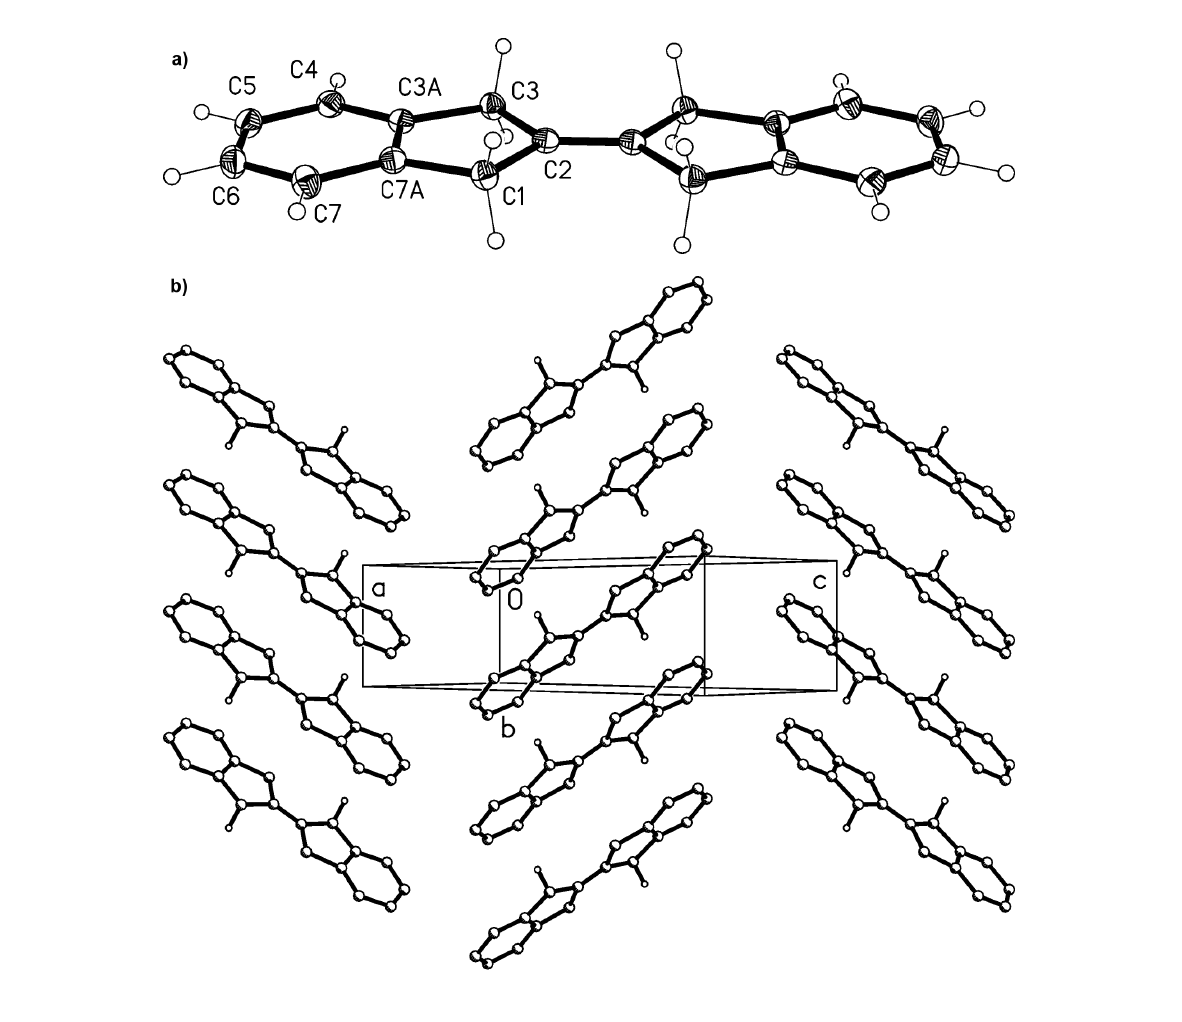
Figure 6: a) The molecule of compound 30 in the crystal. Ellipsoids represent 50% probability levels. Only the asymmetric unit is numbered. b) Packing diagram of compound 30 viewed perpendicular to (102). C–H··· π contacts to the centroid of the six-membered ring can be recognized, but are not drawn explicitly. H atoms not involved in these contacts are